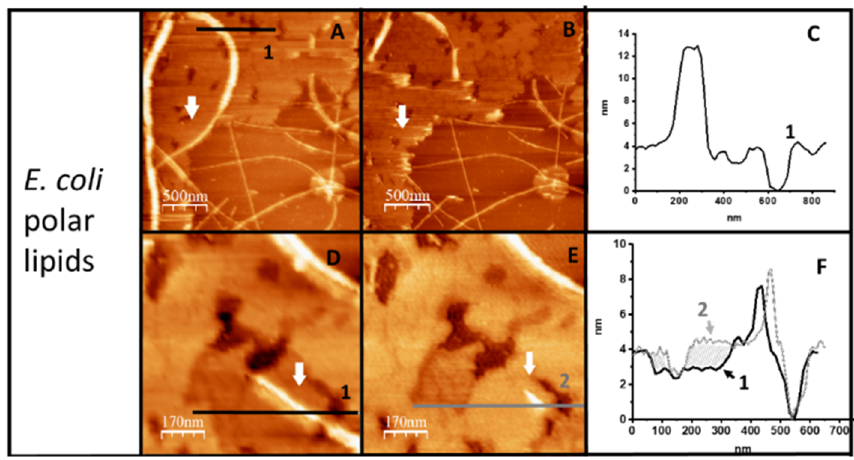
Figure 2. Lipid membrane and filament remodeling. Image in panel ( B ) was taken 20 min after (A). Panel ( C ) shows the height profile below the numbered line in ( A ). Panels ( D , E ) are a zoom of the same region showing the detail of filament and membrane evolution in twenty minutes (white arrows, indicate the same region). ( F ) shows the superimposed profiles in ( D , E ) illustrating that filament disappearance is associated with an increase in the thickness of the membrane (shaded area). Note that, as shown in Supplementary Figure S2, the monomeric peptide itself also interacts with the negatively charged lipids from E. coli